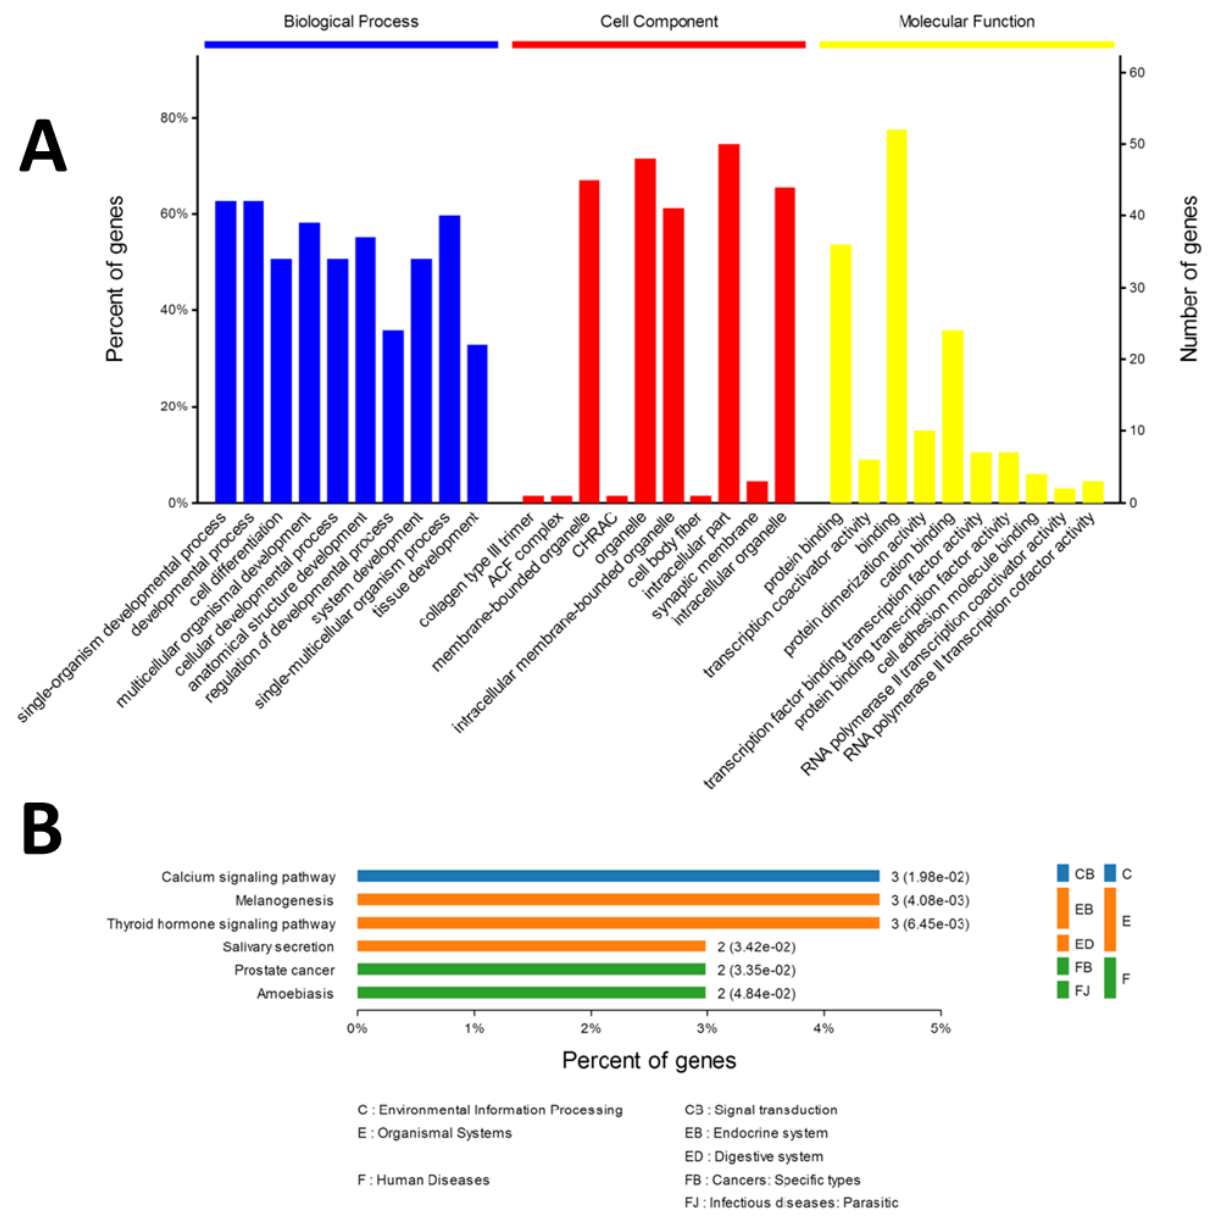
Figure 1: Gene Ontology analysis of prolactinomas. A: Differentially expressed mRNAs (fold change > 2 and false discovery rate q< 0.1) between the invasive and non-invasive groups of tissue were analyzed using hierarchical clustering. Each row represents a single mRNA and each column represents an individual sample. Red indicates relatively high expression and green indicates relatively low expression. B: KEGG pathways. KEGG pathway analysis showed the calcium signaling pathway, melanogenesis and the thyroid hormone signaling pathway were involved in pathogenesis and cell